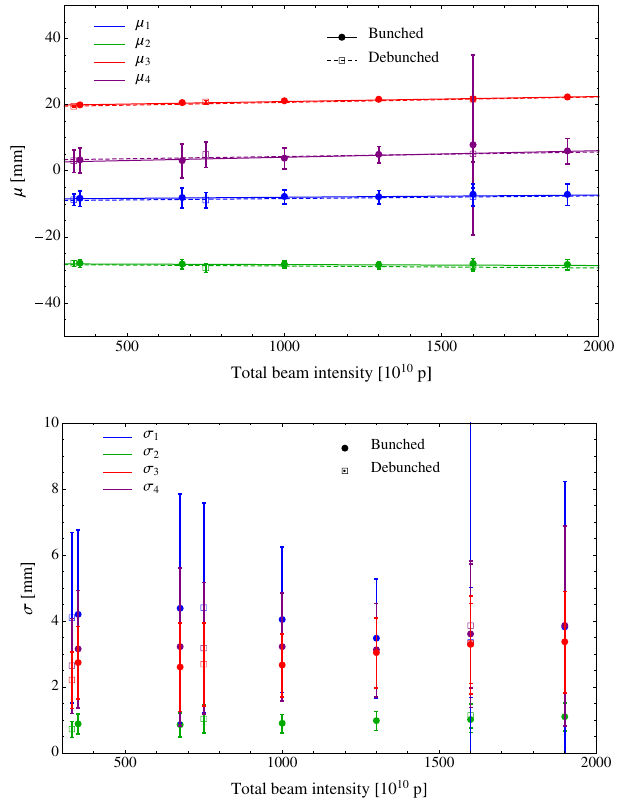
FIG. 13. Beamlets’ position (cid:5) i , from the fit using Eq. (6) of the data collected during the second experimental campaign, vs total beam intensity (upper plot). The data from the debunched as well as bunched beam are shown. The excellent quality of the linear fit of (cid:5) i vs intensity is clearly visible. The differences between the two beam types seems negligible. The beamlets’ size (cid:6) i vs total beam intensity is also shown (lower plot) and no clear dependence on the beam intensity is visible.